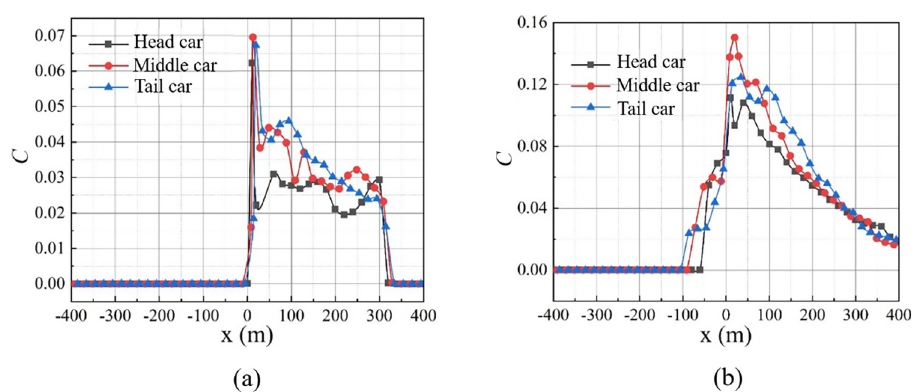
Fig 15. Distribution of smoke concentration for different fire locations. (a) t = 100 s; (b) t = 250 s. https://doi.org/10.1371/journal.pone.0279818.g015 Table 5. Smoke concentration for different fire locations at t = 250